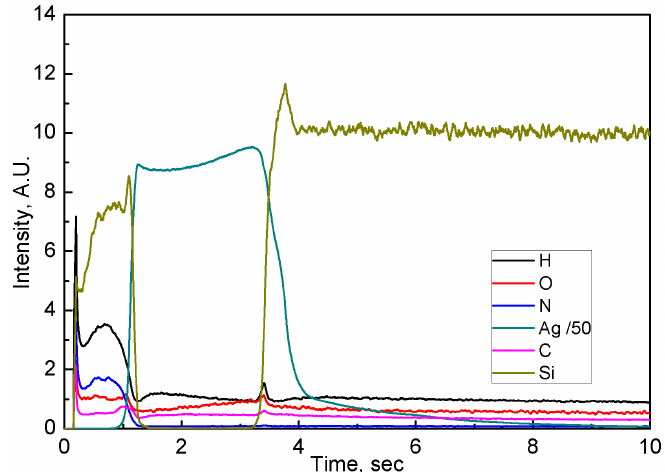
Figure 7. GD-OES profiles of the elements in a not-treated with O 2 plasma SiN x /Ag mirror. Silver signal intensity is divided by 50. The silver layer is fully covered by SiN x :H; all interfaces are re- solved.